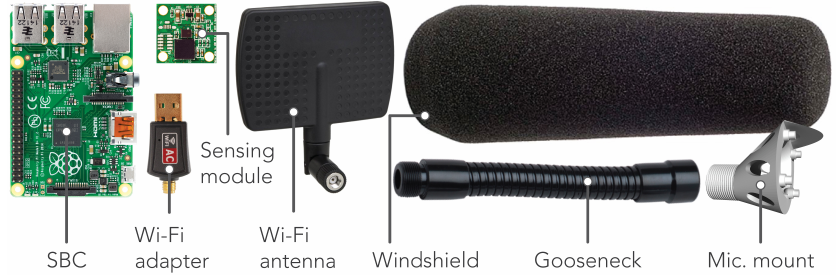
Figure 4. Main part list for complete node at relative scale (excluding housing).